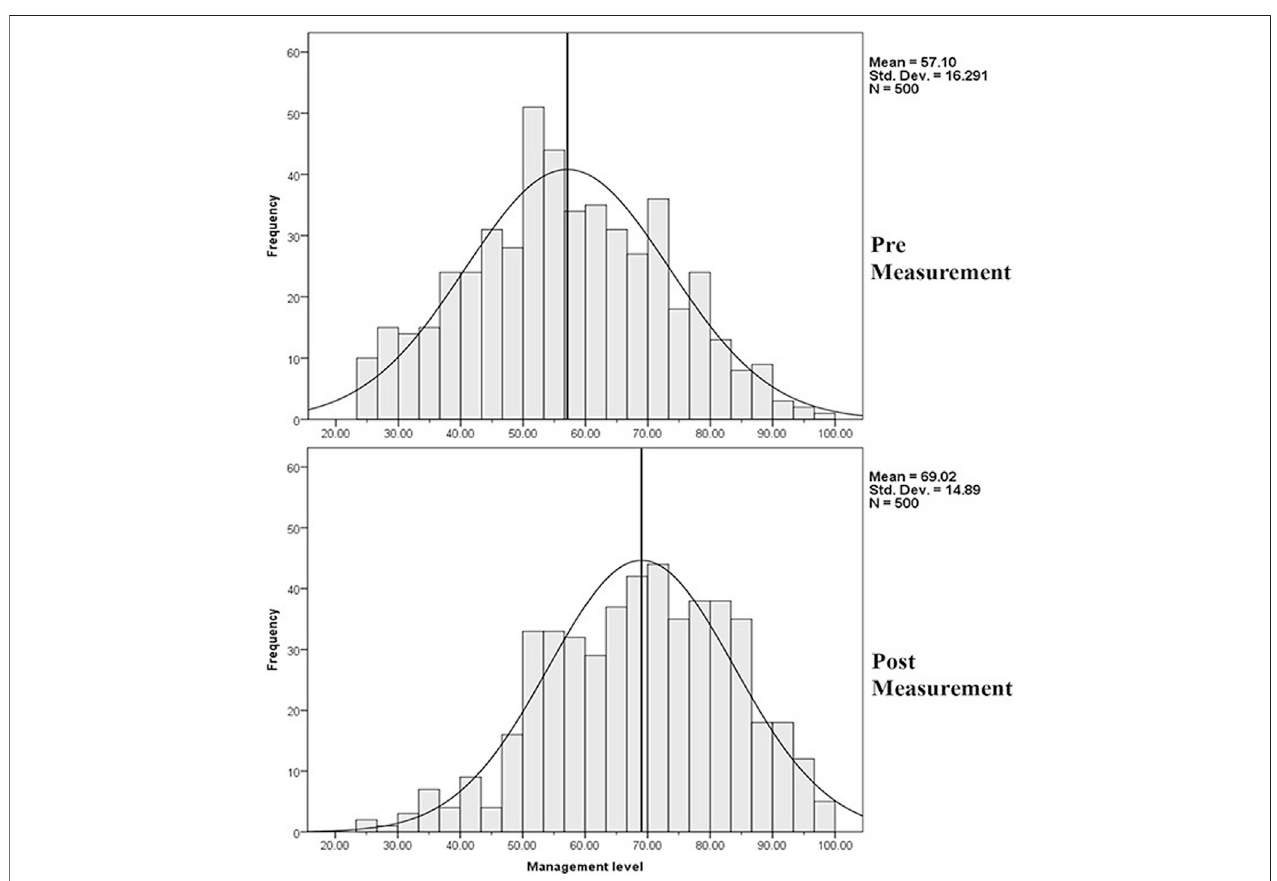
FIGURE 3 | Frequencies of the school scores in the management level. In the graph are presented the results from the pre- and the post-measurements. The vertical line illustrates the mean value of school scores.